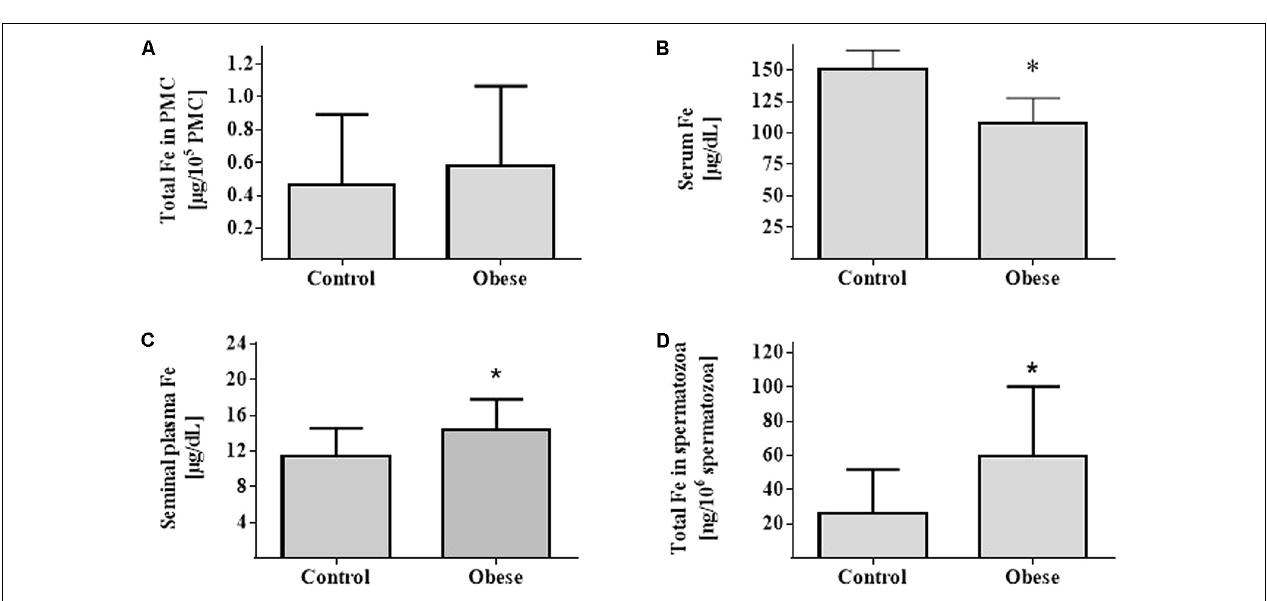
FIGURE 5 | Measurement of Iron. Fe content in PBMCs (A) , serum (B) , seminal plasma (C) , and spermatozoa (D) (Control group; n = 17) (Obese group; n = 17). Values are median and range interquartile. Mann–Whitney test. ∗ Indicates significant